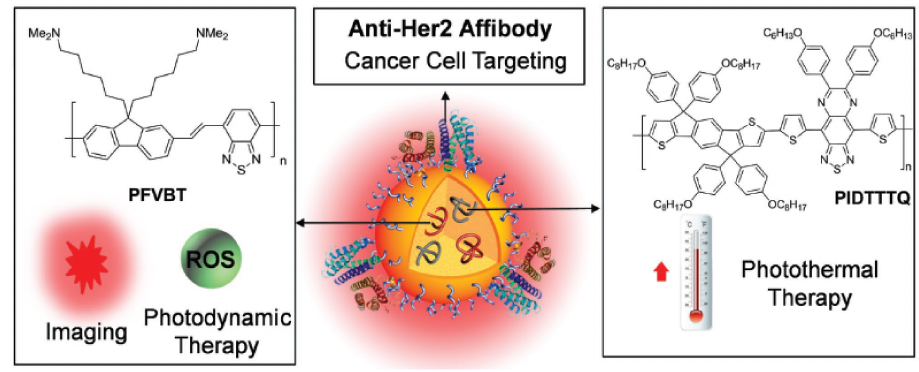
Figure 15. Schematic illustration of the components and functions of anti-HER2-CPNPs consisting of 57 , 58 and DSPE-PEG 2000 -maleimide. Reproduced with permission [68]. Copyright: 2017, Wiley. Finally, Gesquiere and coworkers used MEH-PPV (see Figure 6) as a photosensitizer for photodynamic therapy [69,70]. Due to its high extinction coefficient and easy intersystem crossing to the triplet state, ROS are readily generated. For specific targeting of cancer cells with overexpressed folate receptors (OVCAR3), blended MEH-PPV NPs with amphiphilic PS-PEG-COOH were formulated. The NPs could be functionalized with folic acid through the carboxylic acid groups. The functionalized particles were found to exhibit no dark cytotoxicity and appeared selective for the OVCAR3 cell line, resulting in near complete cell death.